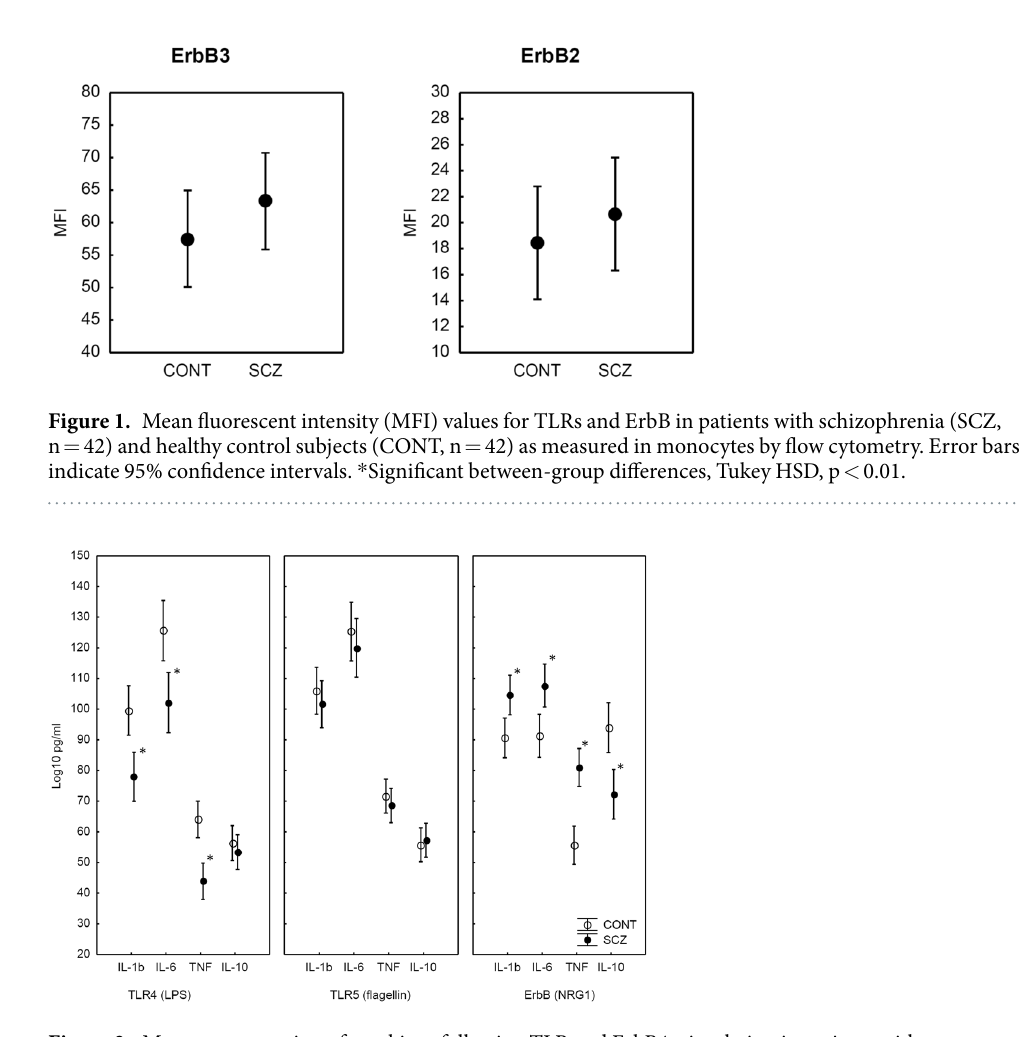
Figure 2. Mean concentration of cytokines following TLR and ErbB4 stimulation in patients with schizophrenia (SCZ, n = 42) and healthy control subjects (CONT, n = 42). Error bars indicate 95% confidence intervals. * Significant between-group differences, Tukey HSD, p <